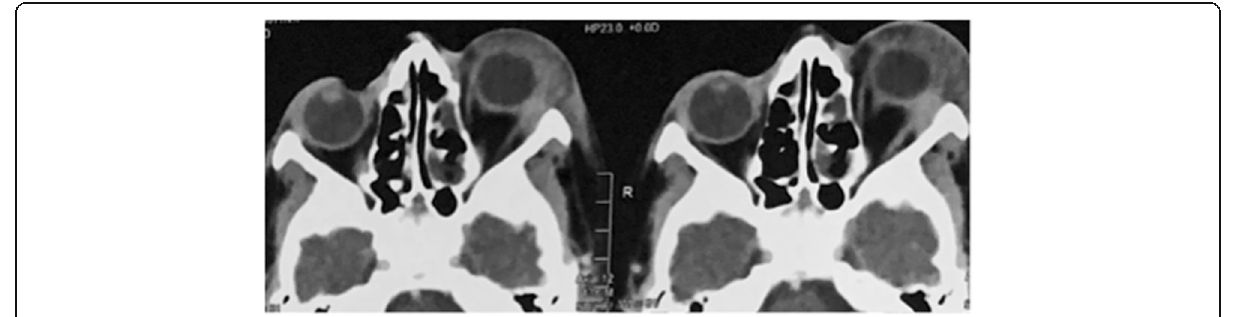
Fig. 3 Axial orbital CT scan showing left orbital cellulitis with axial proptosis